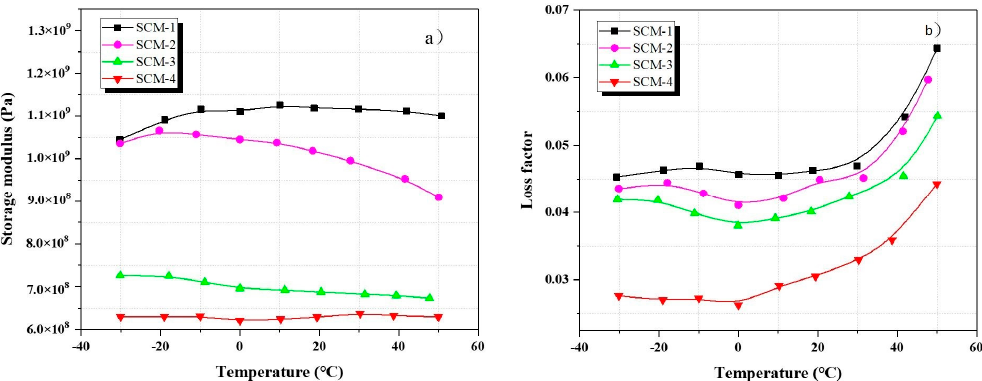
Figure 7. Samples under varying coral sand replacement rates and temperature for frequency of 0.5 Hz at 28 days: ( a ) Storage modulus; ( b ) loss factor.